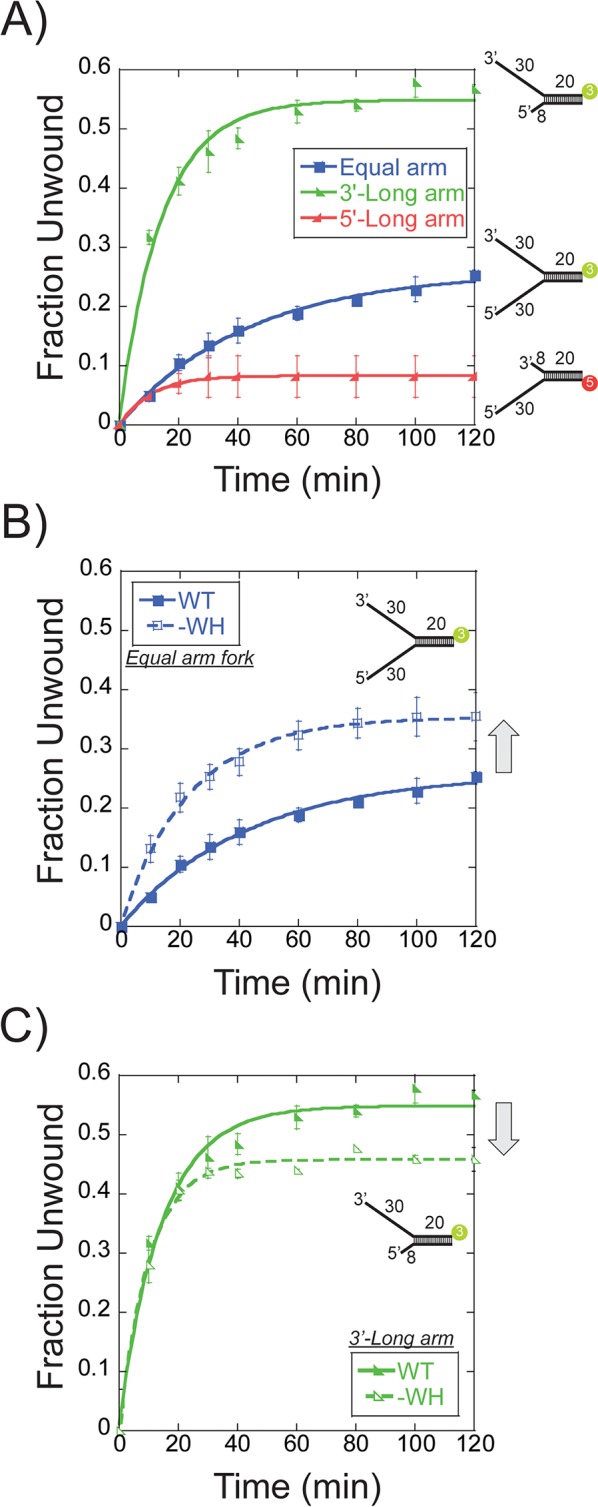
Single turnover DNA unwinding.(A) DNA unwinding of equal arm (in blue boxes -■-, 5’-Cy3 labelled at the duplex), 3’-long arm (in green lower left triangle -◣-, 5’-Cy3 labelled at the duplex), 5’-long arm (in red lower right triangle -SsoMCM WT. Experiments were simultaneously initiated with ATP and an unlabelled ssDNA trap oligo identical to the labelled strand as described in the Materials and methods. (B) DNA unwinding of equal arm fork DNA substrate (5’-Cy3 labelled at duplex) with SsoMCM WT (in closed boxes -■-) and –WH (in open boxes -□-). There is an increase in total DNA unwound with –WH compared to WT (grey arrow). (C) DNA unwinding of 3’-long arm fork DNA substrate (5’-Cy3 labelled at duplex) with SsoMCM WT (in lower left closed triangle -◣-) and –WH (in lower left open triangle -◺ -). There is a decrease in the total DNA unwound with –WH compared to WT (grey arrow). Error bars represent standard error from 3 to 5 independent experiments and data was fit to Equation 3.